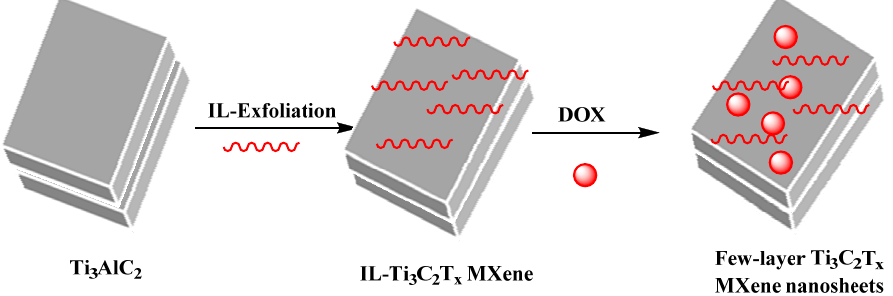
Figure 9. The preparation of few-layer Ti 3 C 2 Tx MXene nanosheets with high chemical stability using an IL-assisted exfoliating (red patterns) method for photoacoustic imaging-guided synergistic photothermal/chemotherapy of tumors [104].